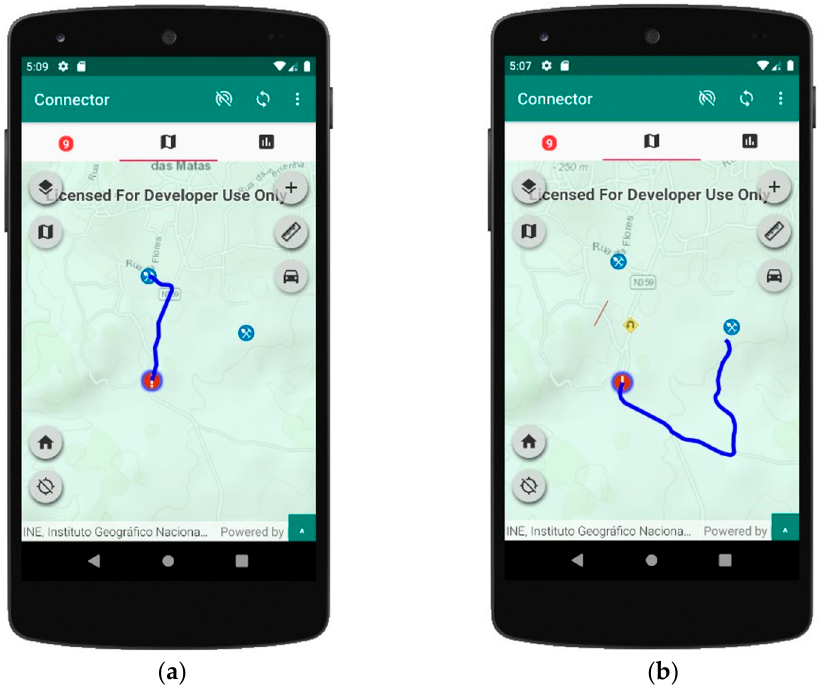
Figure 5. Demonstration of the closest water supply location functionality: ( a ) without and ( b ) with obstacles. ( b ) with